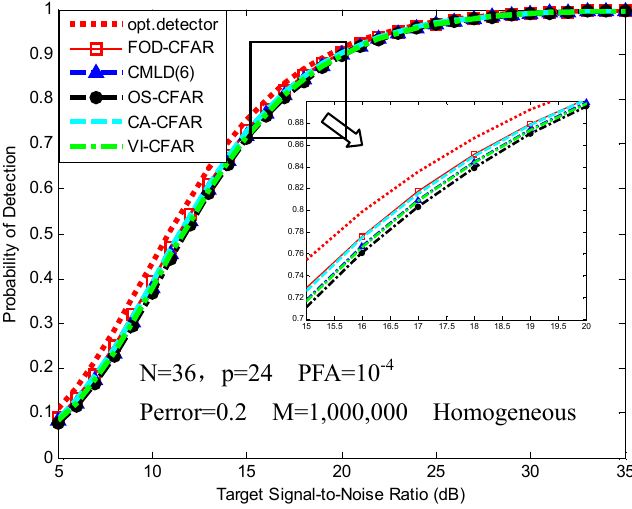
Figure 6. PD comparison of FOD-CFAR, censored mean level detector (CMLD)(6), order statistic (OS)-CFAR, cell-averaging (CA)-CFAR, variability index (VI)-CFAR in a homogeneous